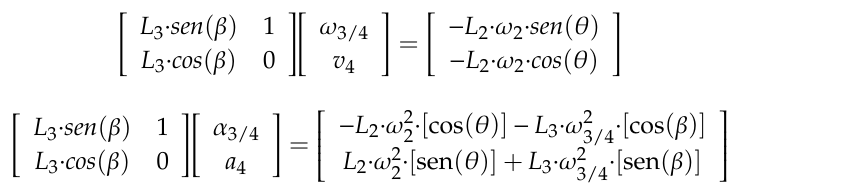
Figure 3. Free-body diagrams for ( a ) the crankshaft, ( b ) connecting rod and ( c ) piston.